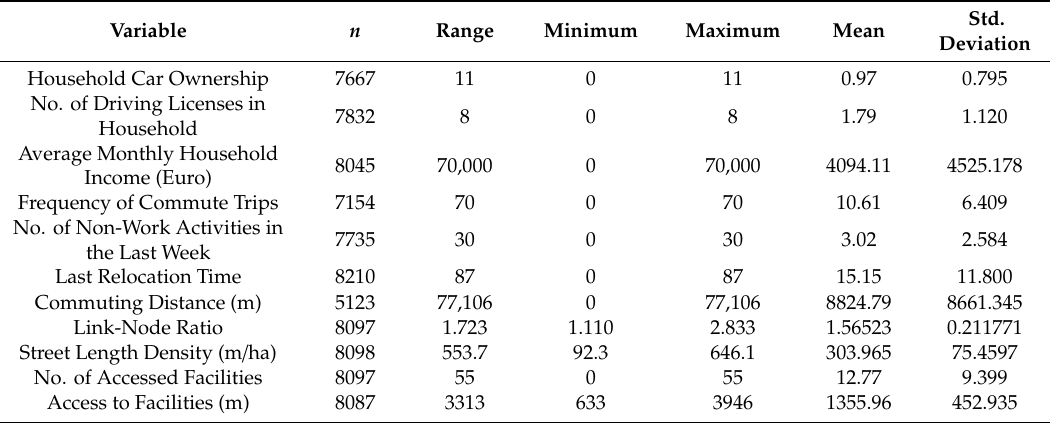
Table 2. Descriptive statistics of the continuous variables of the Weighted Least Squares (WLS) models.